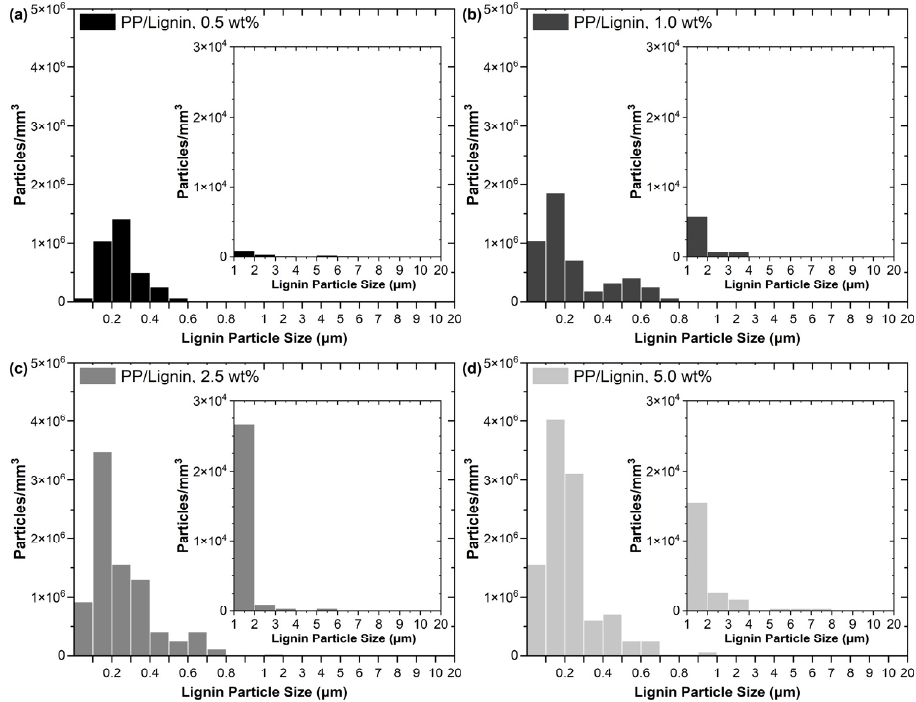
Figure 3. Histograms showing lignin size distributions in the PP/lignin foams with ( a ) 0.5, ( b ) 1.0, ( c ) 2.5, and ( d ) 5.0 wt% of lignin.